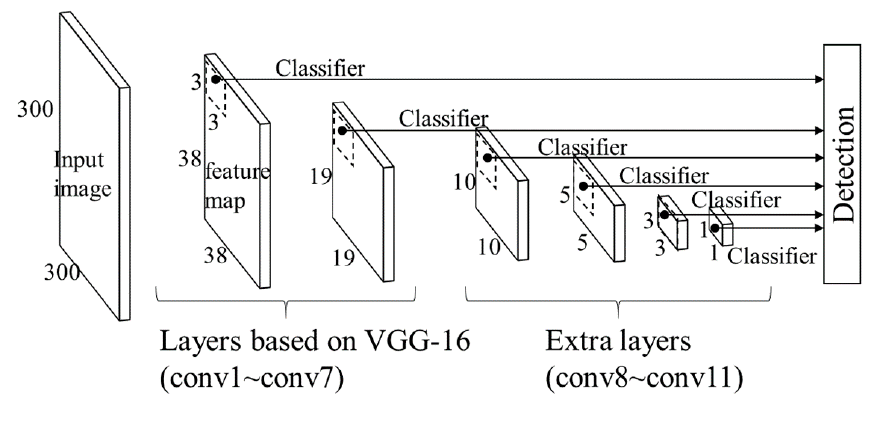
Figure 1. Single Shot Multibox Detector (SSD) architecture.